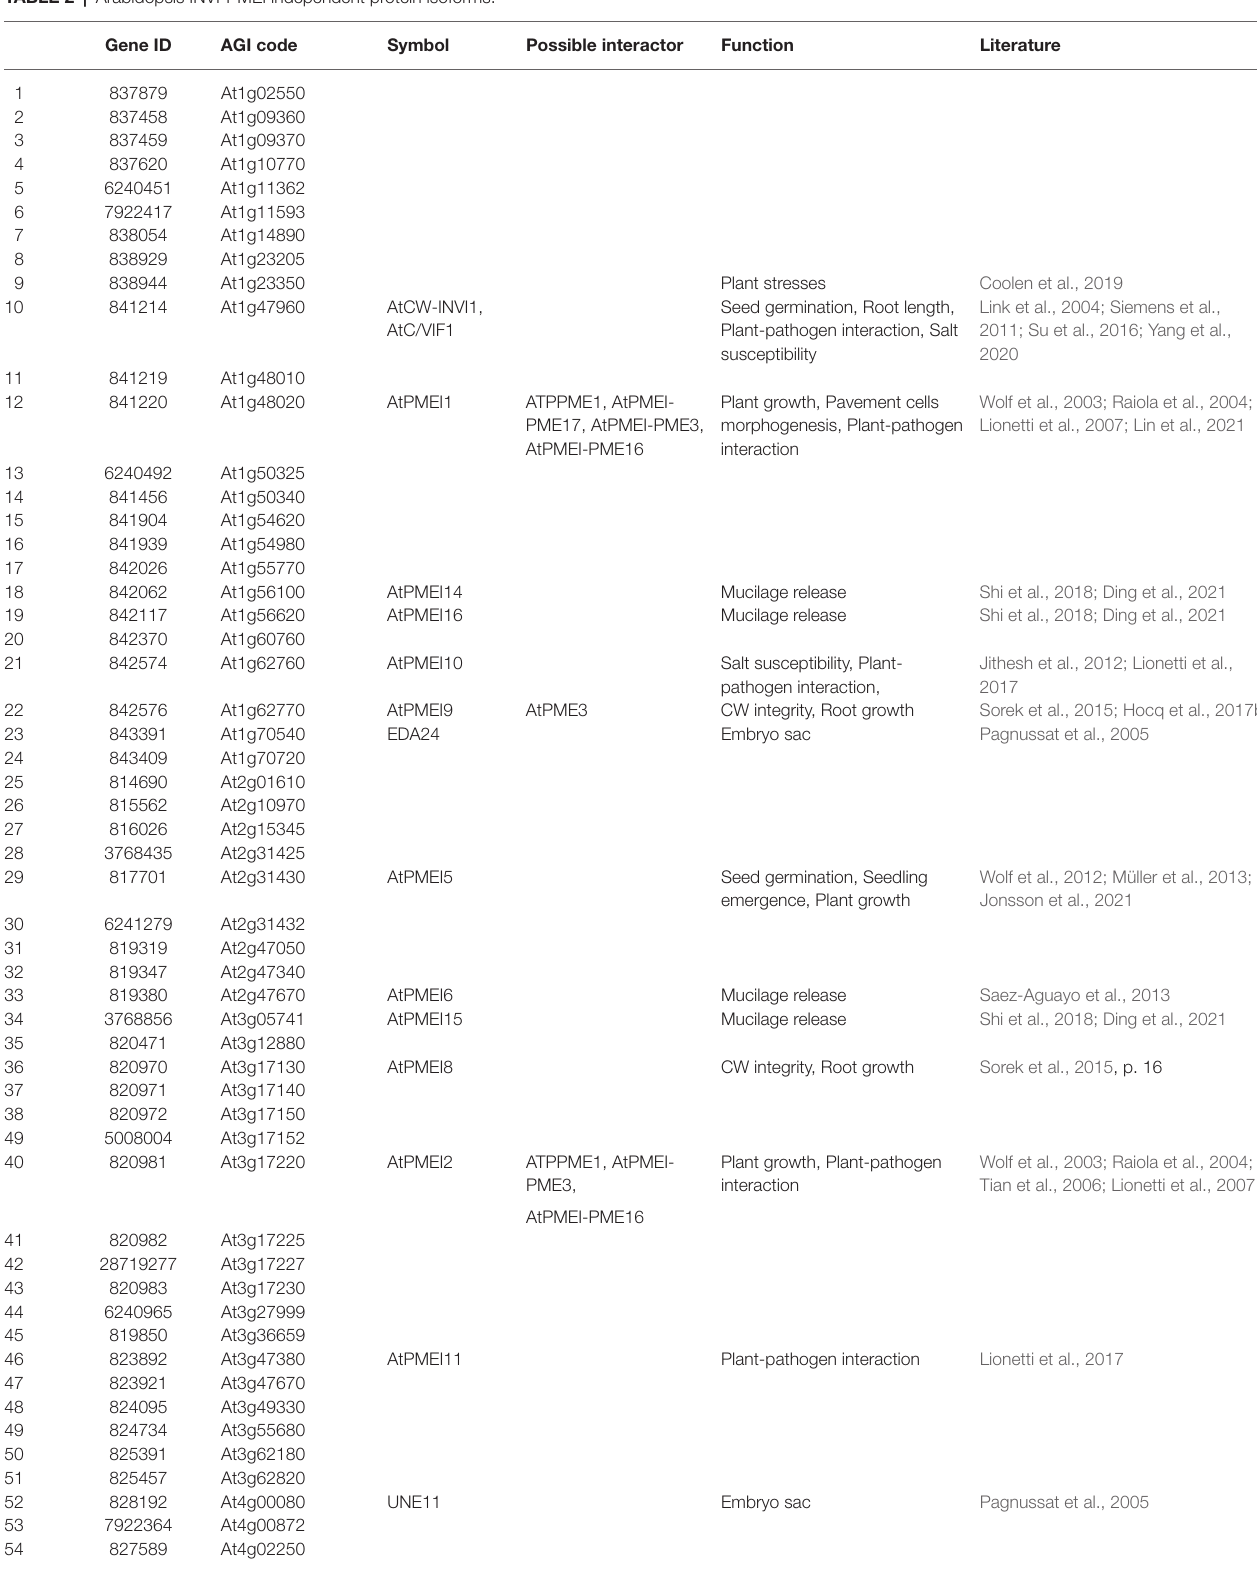
TABLE 2 | Arabidopsis INVI-PMEI independent protein isoforms. Gene